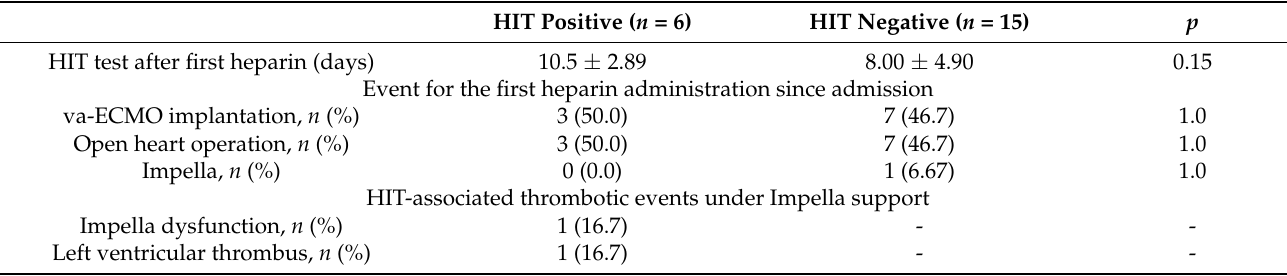
Table 2. Platelet counts decrease due to HIT.